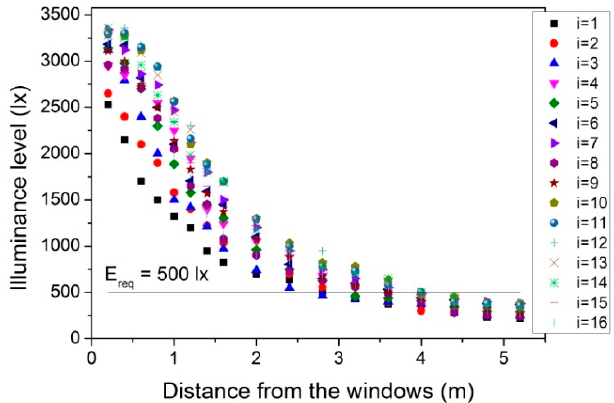
Figure 3. Daylight illuminance level distributions in the classroom depth in April and illuminance level outside the building of 8600 lx.